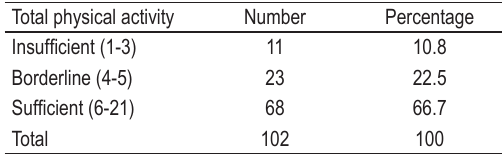
TABLE 1. Physical activity of the respondents